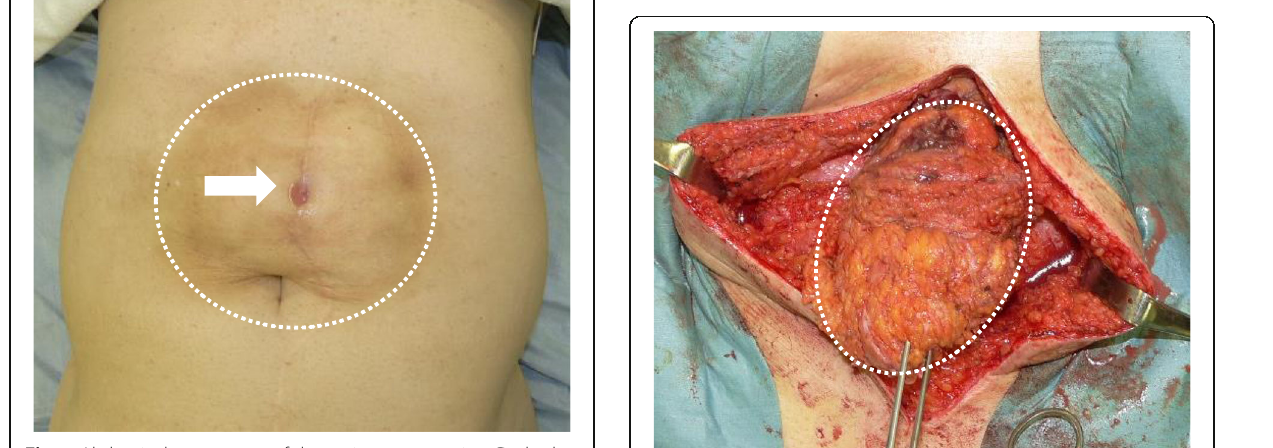
Fig. 1 Abdominal appearance of the patient at operation. Dashed circle shows the range of palpable subcutaneous fluid collection and an arrow indicates the skin fistula